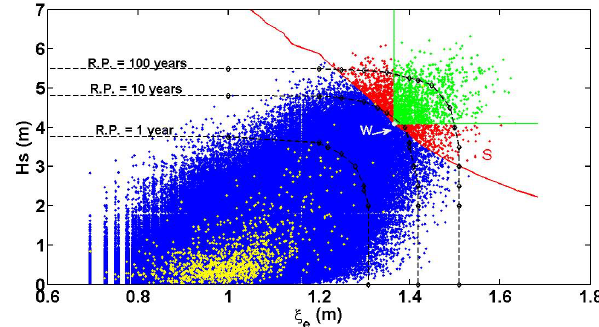
Fig. 8. Illustration of the results for point MIR1. The original data points (independent events) are represented by yellow dots while simulated combinations are represented by blue dots. The black curves represent the contours of iso-joint exceedance return period. The red curve is the limit of S (combinations that lead to exceedance of R C ) which is represented by red dots. The joint exceedance do- main for the combination W which represents the worst case of S is pictured in green (i.e. the combination whose joint exceedance return period is the